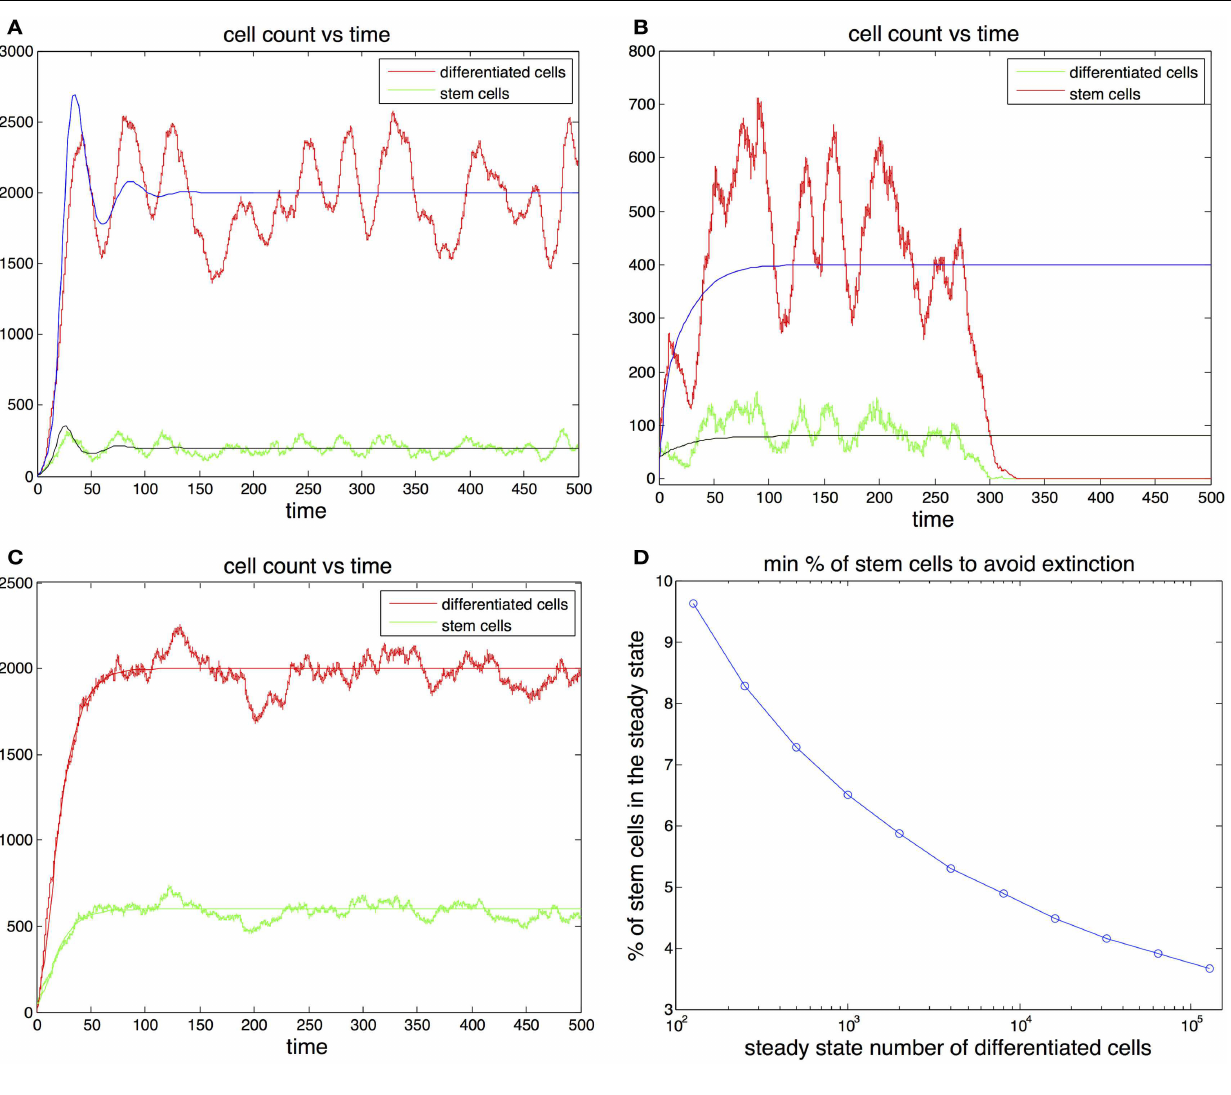
FIGURE 3 | (A,B) Cell population with one feedback loop.The stochastic simulation is shown in red for differentiated cells and green for stem cells.The ode is shown in blue for differentiated cells and black for stem cells. Parameters in (A) p 0 = 0 . 6 , d = 0 . 1 , g = 0 . 0001 , h = 0 , S (0) = 10 , D (0) = 0 . Parameters in (B) p 0 = 0 . 52 , d = 0 . 2 , g = 0 . 0001 , h = 0 , S (0) = 40 , D (0) = 0 . (C) Cell population with two feedback loops. Feedback in the division rate dampens oscillations. Parameters are the same as in (A) with the exception h = 0 . 001 . (D) Sufficient conditions for